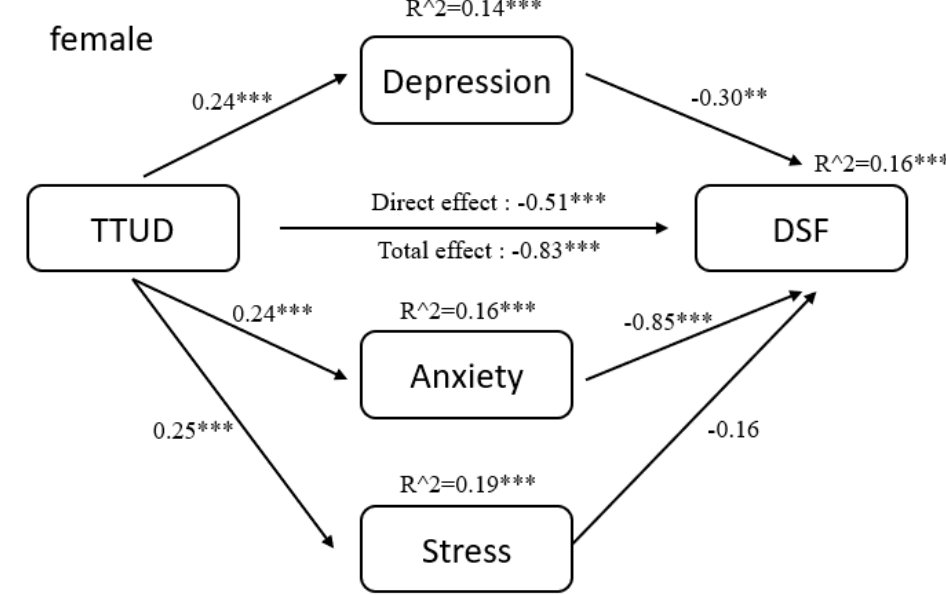
Figure 6. Structural model of forward digit span test for female participants. ** p < 0.01, *** p < 0.001.